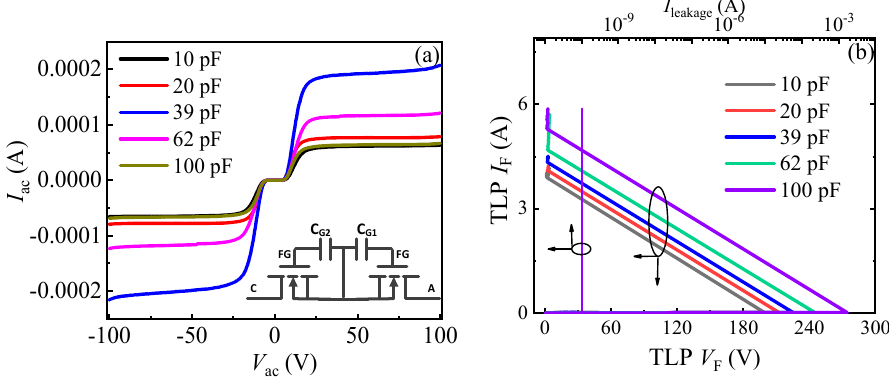
Figure 9. The leakage current characteristics ( a ) and TLP I–V characteristics ( b ) of diode 1 with different C G1 ( C G2 ) values. The inset of Figure 9a is the equivalent circuit of diode 1.